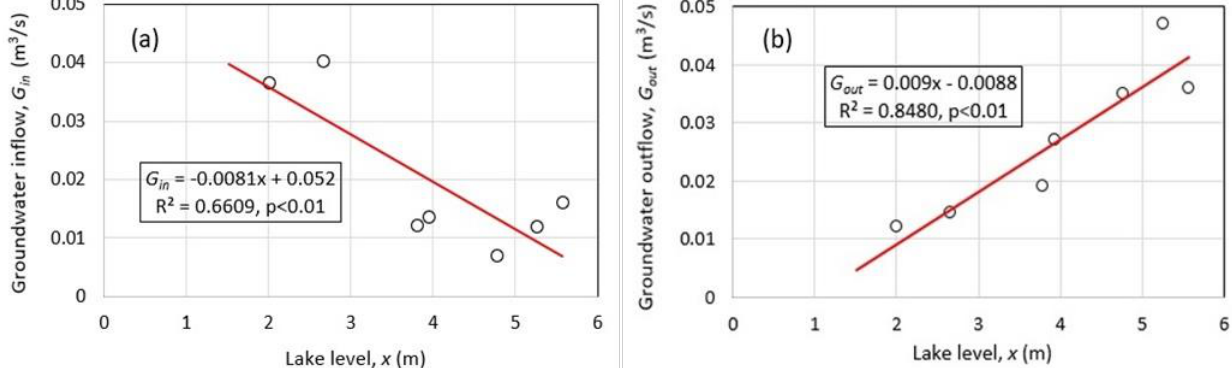
Figure 19. Relations between the lake level and ( a ) groundwater inflow G in or ( b ) groundwater outflow G out calculated in 2020 and 2021 (Table 1).